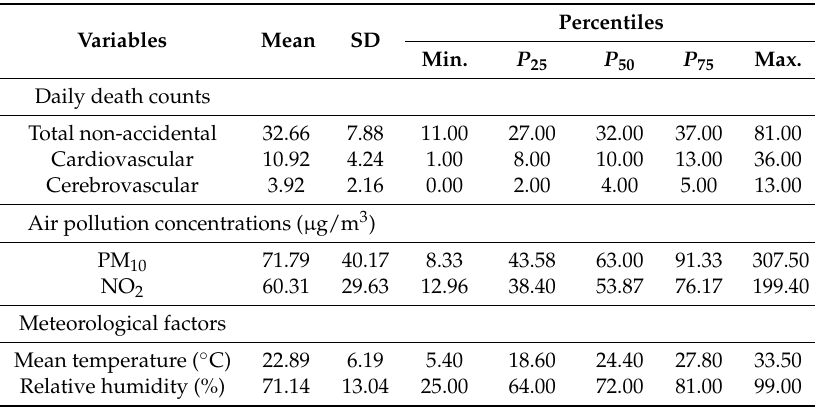
Table 1. Distribution of daily mortality, air pollution concentrations and meteorological factors in Yuexiu and Liwan districts, Guangzhou, China (2006–2010).